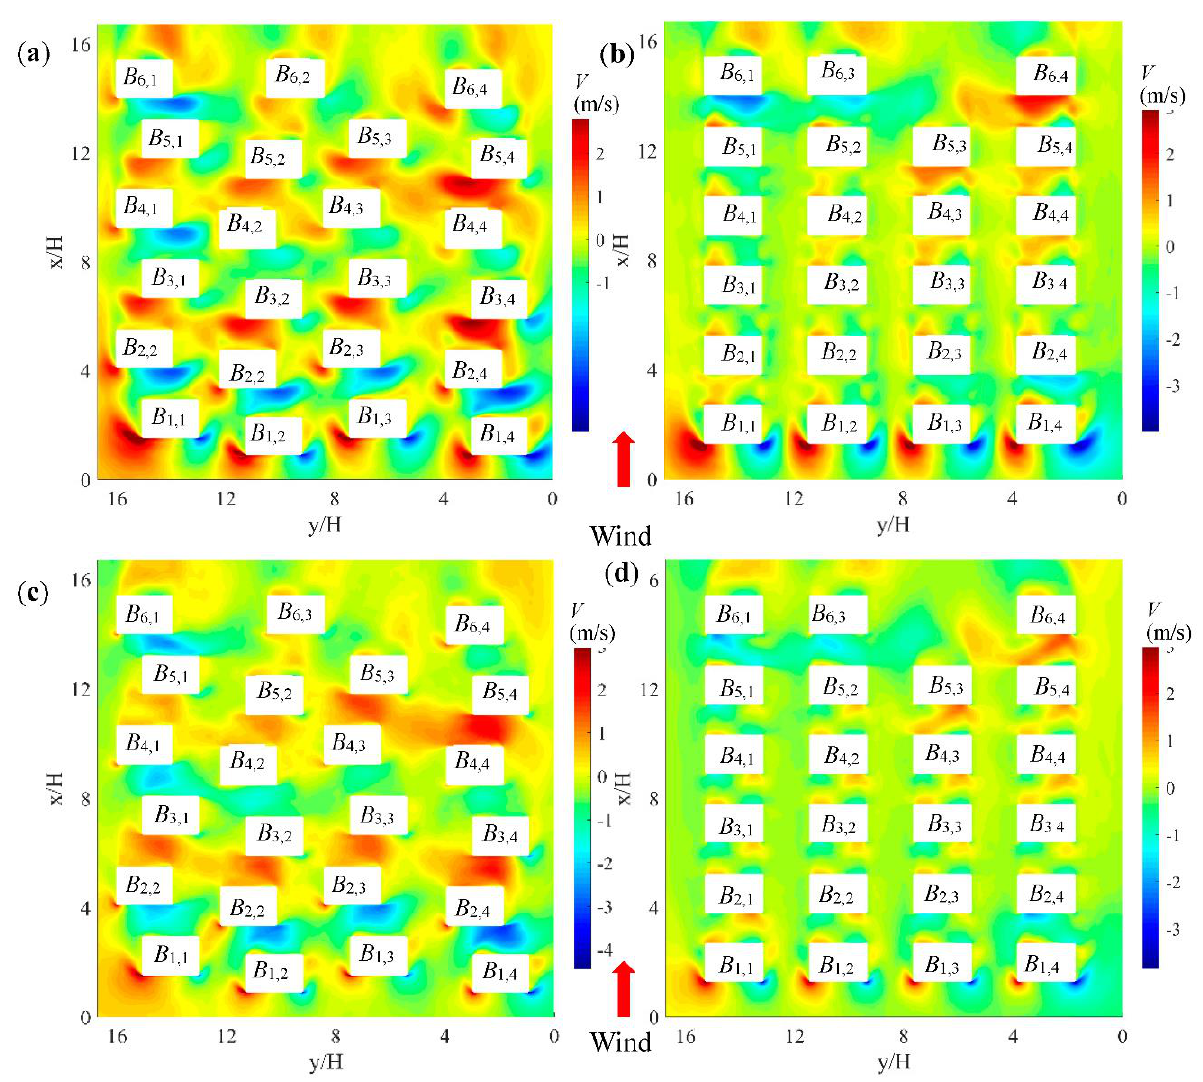
Figure 14. Contours of span-wise mean velocity V at z = 0.06 H for ( a ) DWP ( b ) SWP and at z = 0.5 H for ( c ) DWP ( d ) SWP.